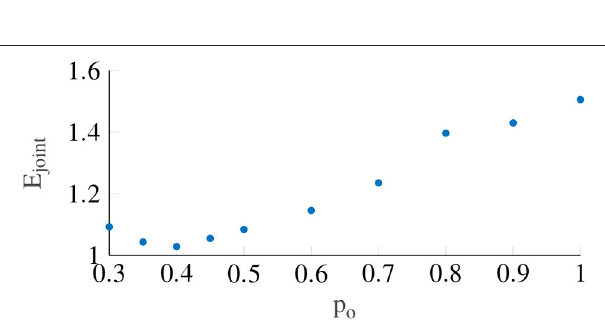
FIGURE 6 | The error term E joint with respect to the output power scaling, which is taken to be constant between participants. The lowest E joint occurs when power is equal to